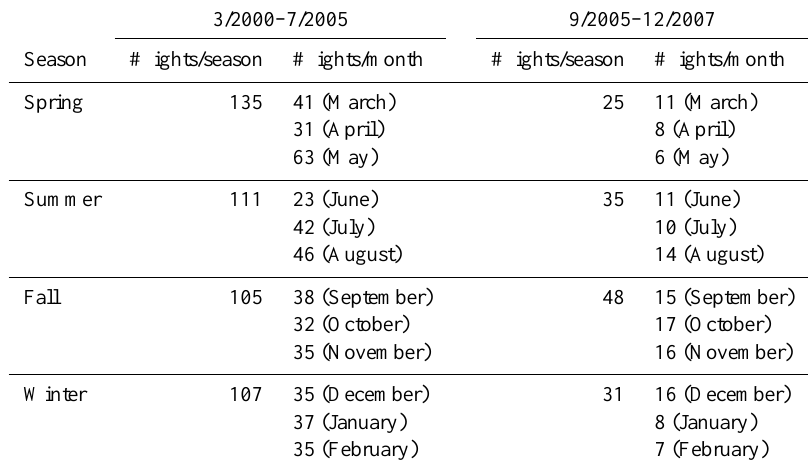
∗ Only flights over the SGP CART site with all 9 (10) level legs are included in this table.